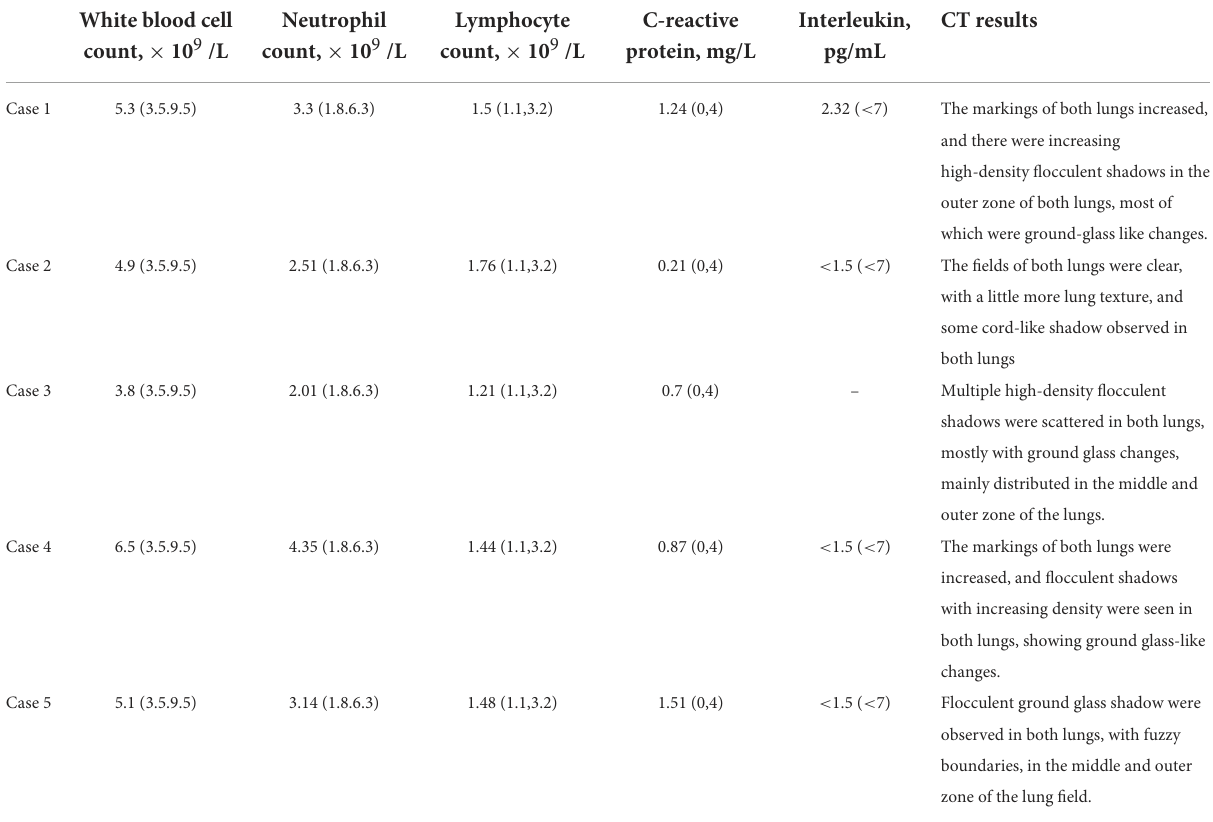
TABLE 2 Baseline laboratory tests and lung CT of study patients. White blood